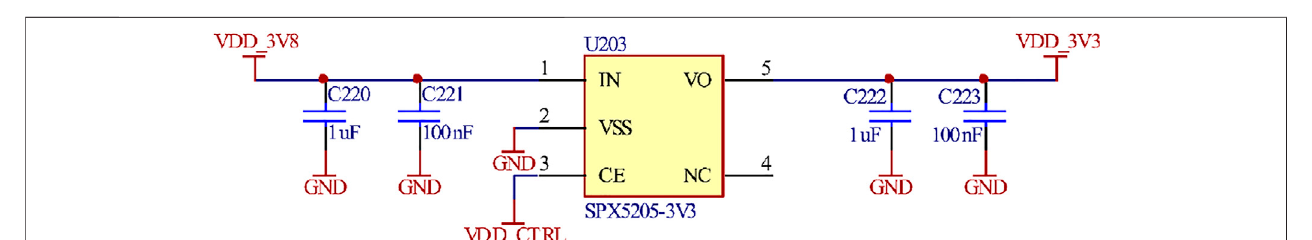
FIGURE 3 | Schematic diagram of 3.3 V power supply circuit.